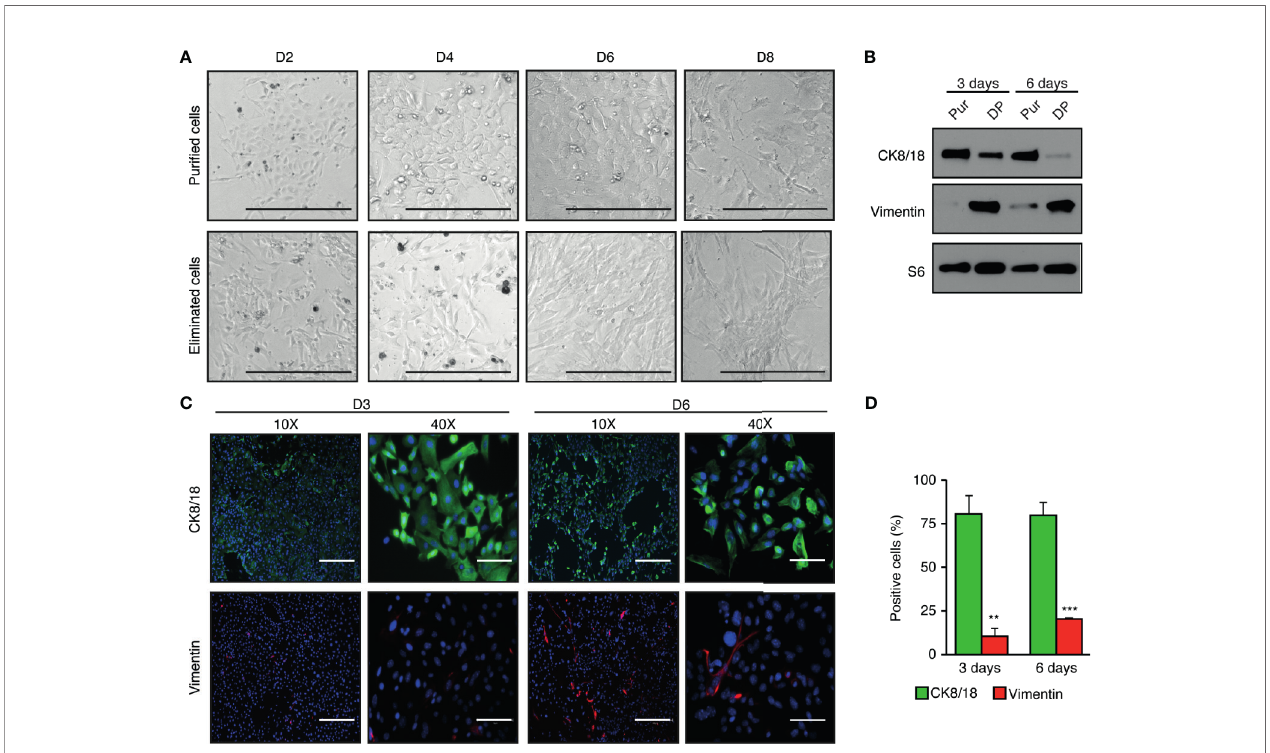
FIGURE 2 | High enrichment of mammary epithelial cell for primary culture in two-dimensions. (A) Bright fi eld images of mammary epithelial cells obtained after puri fi cation compared with the cells eliminated during the puri fi cation process. Scale bars = 300 m m. (B) Western blot analysis of puri fi ed cells normally discarded with differential plating (DP) compared to puri fi ed epithelial cells (Pur). Protein expression of the cytokeratin 8 and 18 (CK8/18), a marker of epithelial cells, and vimentin, a marker of fi broblasts, after three and six days in two-dimensional culture. S6 was used as the loading control. (C) Immuno fl uorescence showing the expression of CK8/18 (green) and vimentin (red) at three or six days in two-dimensional culture. Nuclei were stained with DAPI (blue). Scale bars = 300 m m and 75 m m. (D) Ratios of positive cells for CK8/18 or vimentin per the total number of cells (counts of nuclei) in percentage. Data are shown as mean ± SEM of one representative experiment (n = 6 images per condition). ** p < 0.01; *** p <